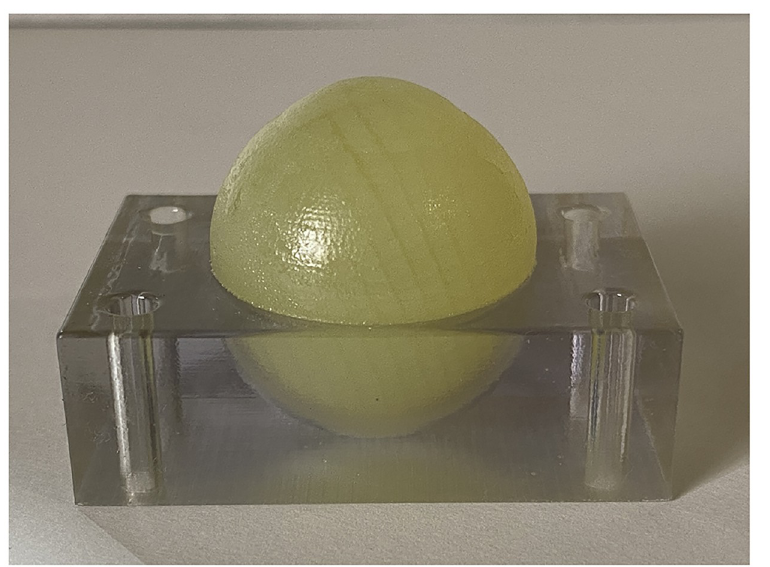
Fig 2. Whole eyeball and holder simulated using 3D-printing technology.